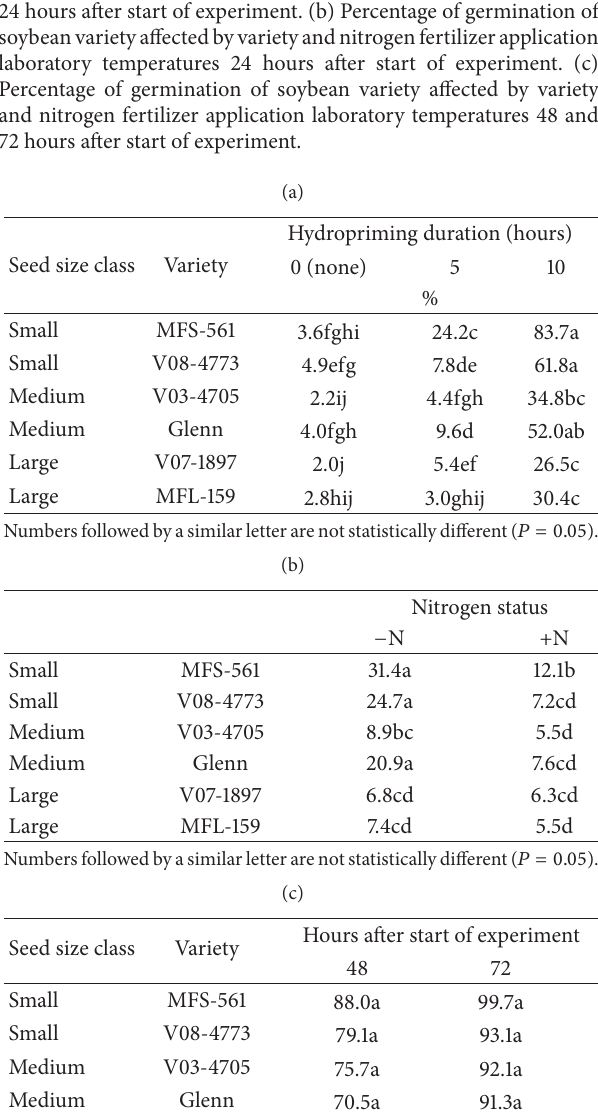
Table2:(a)Percentageofgerminationofsoybeanvarietyaffectedby water priming duration and variety under laboratory temperatures 24 hours after start of experiment. (b) Percentage of germination of soybeanvarietyaffectedbyvarietyandnitrogenfertilizerapplication laboratory temperatures 24 hours after start of experiment.